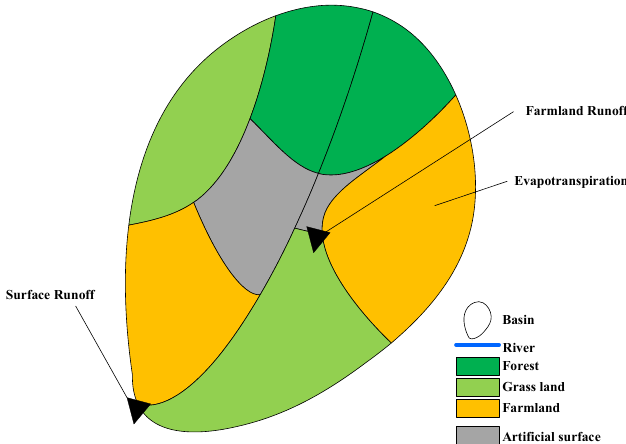
ff , farmland runo ff , and